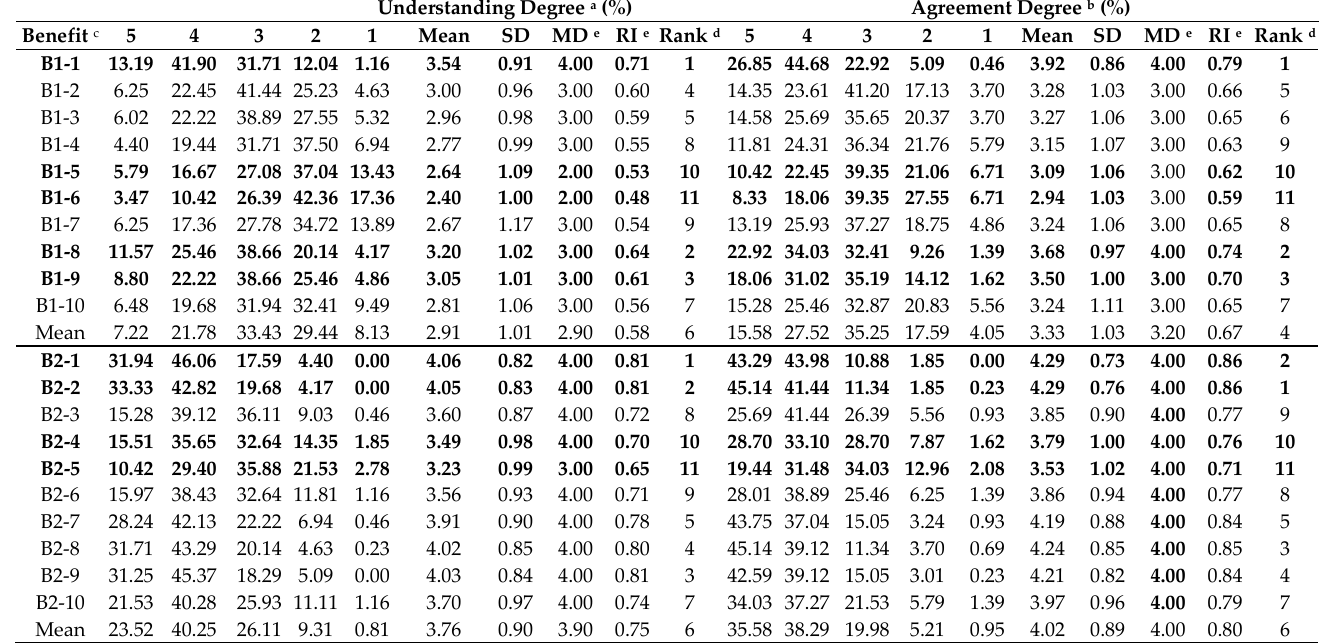
Table 3. The understanding and agreement degrees of respondents concerning UGS’ social benefits.